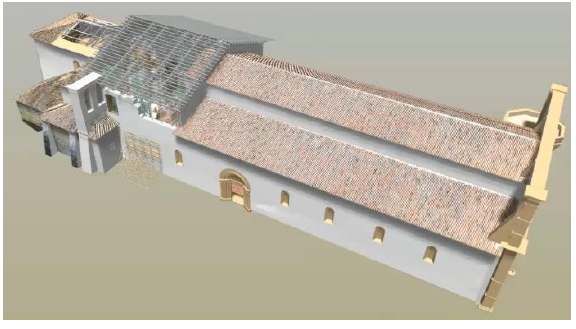
Fig. 12. The BIM along with the projected true-orthoimage.